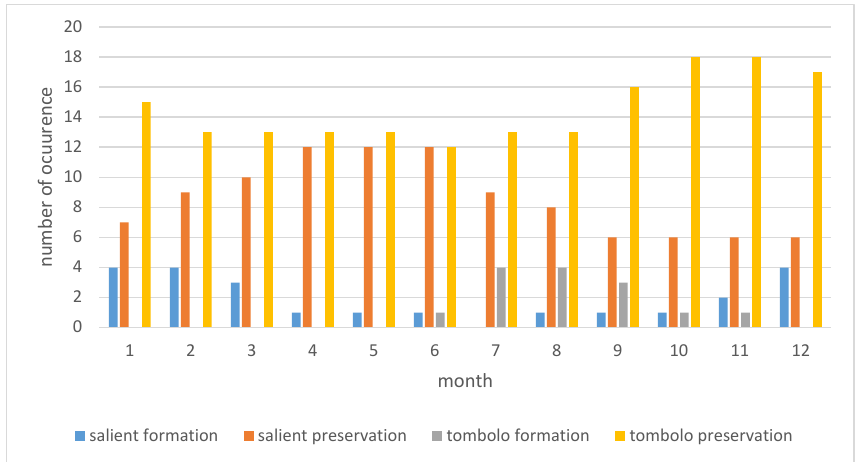
Figure 8. Frequency of occurrence of different states of morphology of the tombolo of Prasonisi extracted from the satellite images covering the period from 10 November 1995 to 8 February 2022.